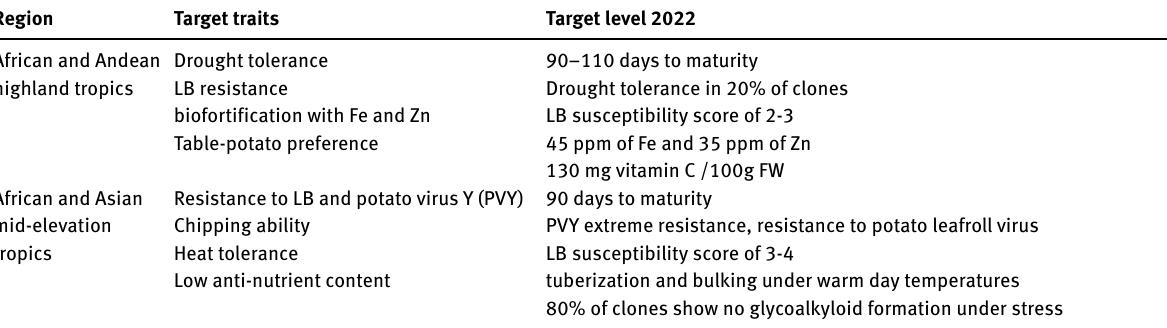
Table 2: Target traits for potato (source: RTB 2016) Region Target